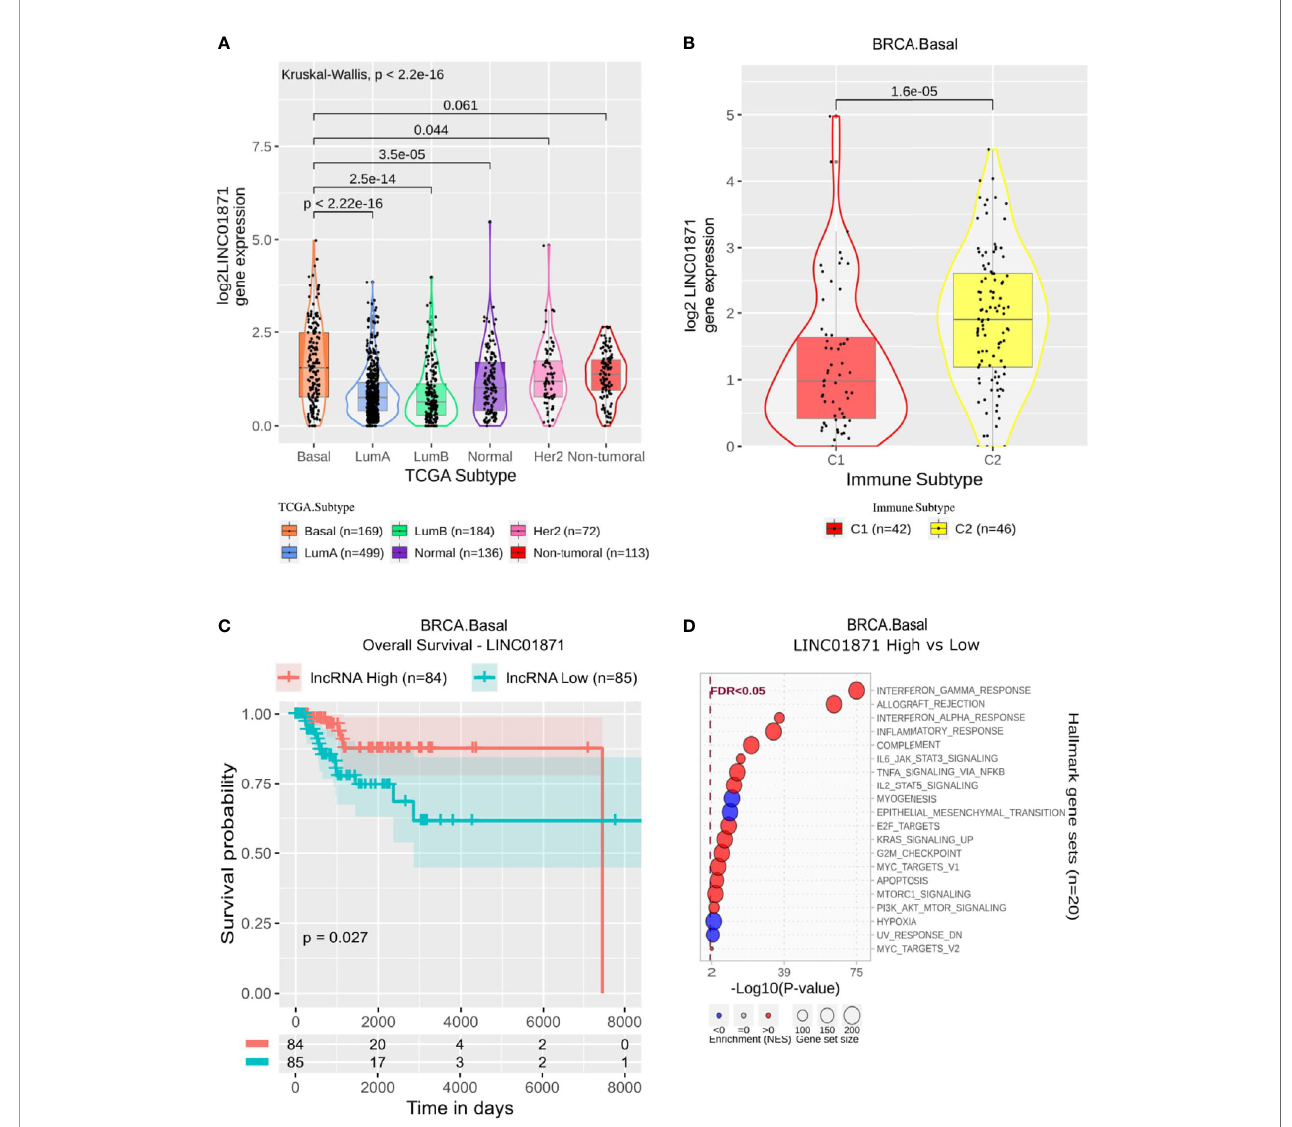
FIGURE 4 | LINC01871 panel representation in basal-like subtype. (A) Box-plots representing LINC01871 expression among all breast cancer molecular subtypes. The Kruskal-Wallis test (p-value represented in the panel left top position) was used to differentiate expression between groups, followed by the Wilcoxon test (p-values represented emphasizing comparisons between subtypes). (B) Box-plot representing LINC01871 in C1 and C2 immune subtypes in basal-like patients. (C) LINC01871 overall survival curves. To de fi ne the two groups, LINC01871 ’ s median expression classi fi ed the patients into “ high ” and “ low ” groups. Logrank p-value represented as 0.027. (D) Enrichment analysis using Hallmarks gene sets. Red circles refers to activation while blue circles to inactivation. In the X axis, a p-value scale is represented. The circle size varies according to the number of genes in the identi fi ed gene